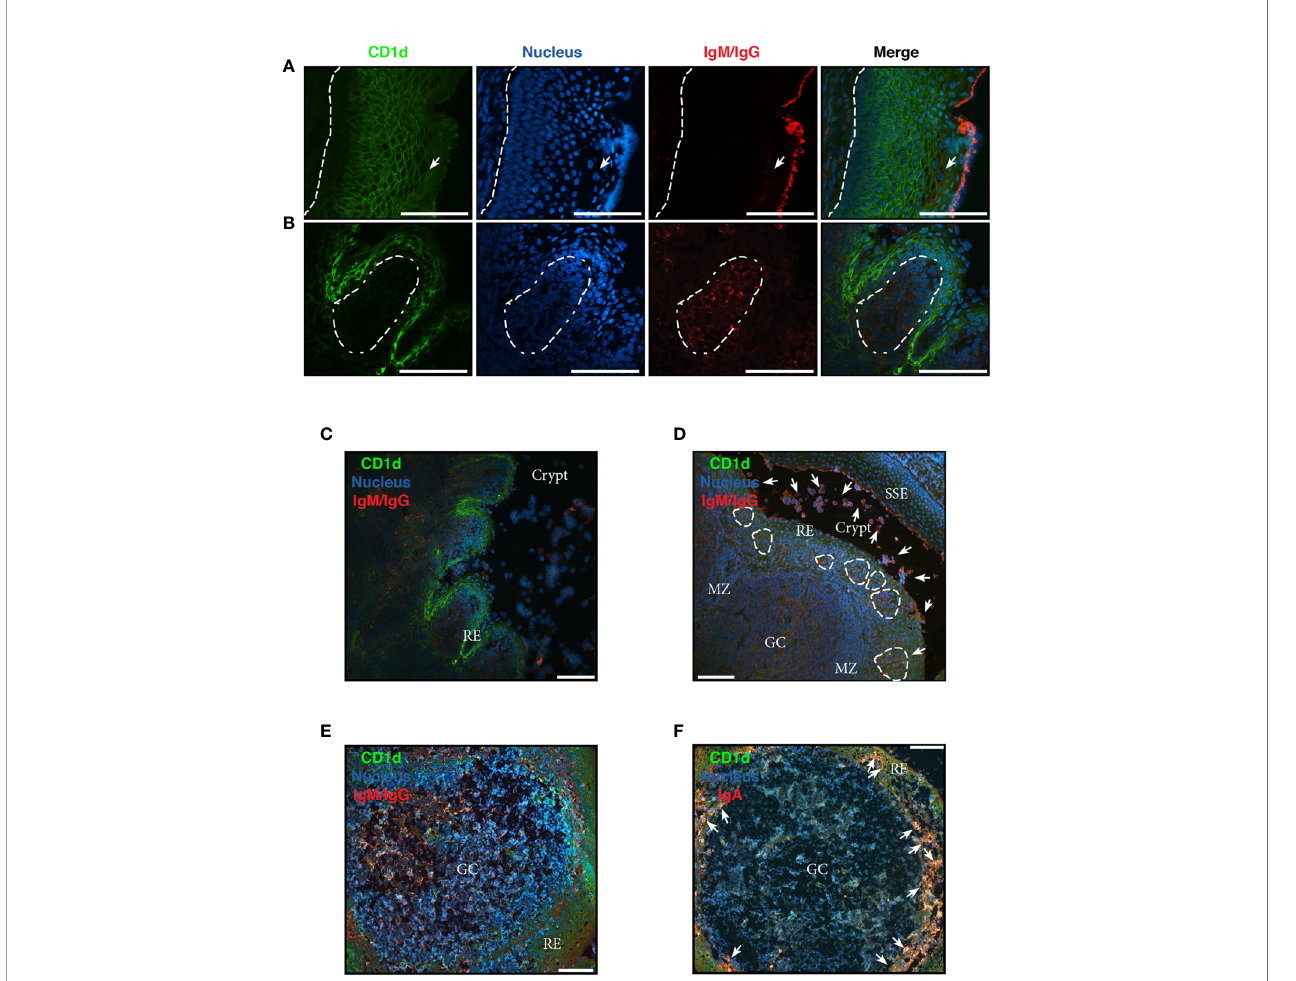
FIGURE 3 | Analysis of chronically in fl amed human tonsils by immunohistology. (A – F) Three-color immuno fl uorescent microscopy of tonsillar frozen sections. (A) Representative immuno fl uorescence staining showing strati fi ed squamous epithelium with CD1d (green), IgG/IgM (red) and nucleus (blue). Dashed line represents the limit between the basal membrane and the epithelium. Arrow indicates IgG + /IgM + plasma and B cells intercalated in the mesh of epithelial cells. (B) Representative immuno fl uorescence staining showing reticular epithelium with CD1d (green), IgG/IgM (red) and nucleus (blue). Dashed lines represent the limit of the follicle. (A, B) Scale bar, 100 µm. (C) A less magni fi ed image of the section shown in (B) to evidence the particular characteristics of the lympho-epithelium covering the crypts. RE stands for reticular epithelium. Scale bar, 100 µm. (D) Representative immuno fl uorescence staining showing a germinal center (GC) with its mantle zone (MZ), the reticular epithelium (RE) over it highly in fi ltrated with lymphocytes. Clusters of B/plasma cells indicated by dashed lines. The crypt and the strati fi ed squamous epithelium (SSE) on the other border of the crypt are also designated in the picture. CD1d (green), IgG/IgM (red) and nucleus (blue) staining. Arrows indicate some of the many IgG + /IgM + B and plasma cells scattered all over the tissue and crypt. Scale bar, 100 µm. (E) Representative immuno fl uorescence staining showing single a germinal center (GC). CD1d (green), IgG/IgM (red) and nucleus (blue) staining. Scale bar, 100 µm. (F) Representative immuno fl uorescence staining showing a single germinal center (GC). CD1d (green), IgA (red) and nucleus (blue). Arrows indicate some of the many IgA + B and plasma cells into the mesh of the reticulated epithelium (RE). Scale bar, 100 µm. Samples were examined with a Nikon Eclipse Ti-E